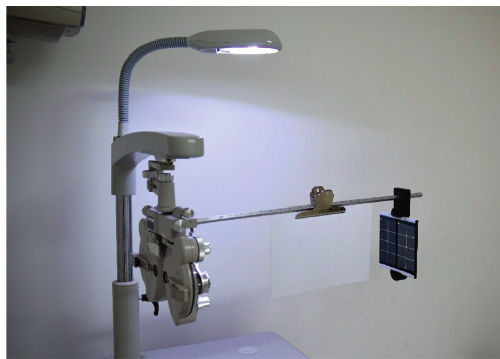
Figure 1: Photograph of the actual